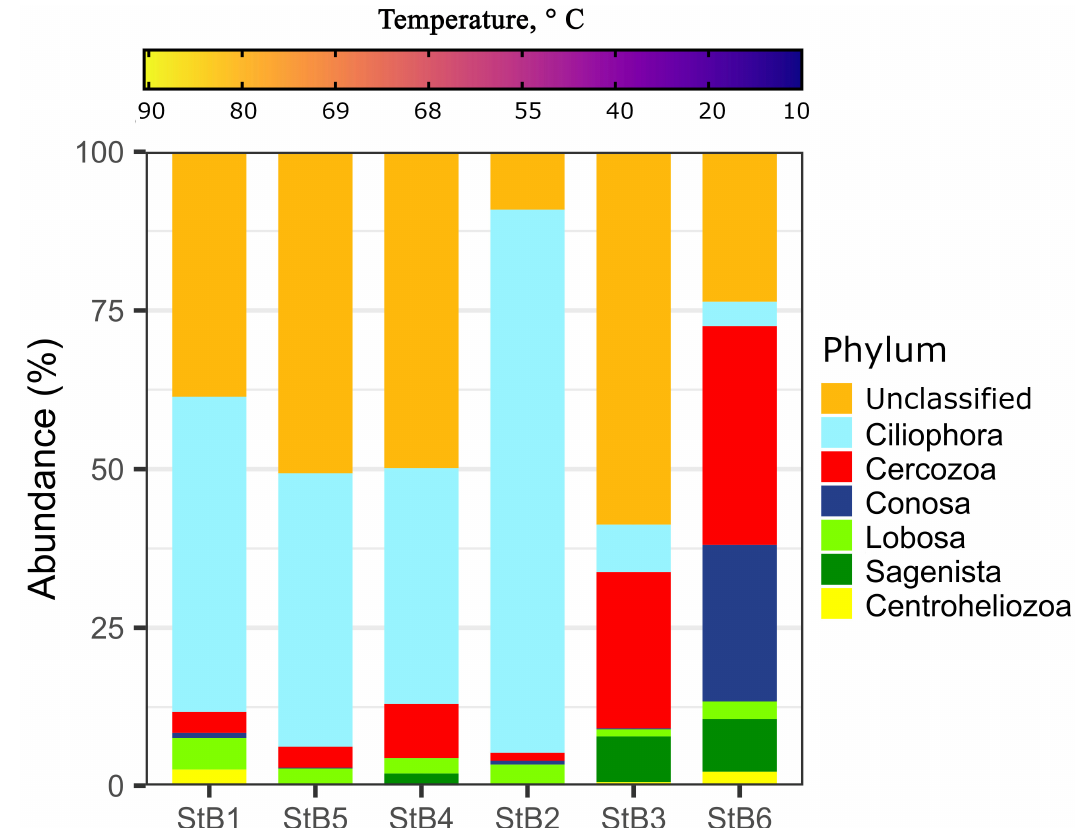
Figure 6. Relative abundances of protists phyla in the microbial biofilms calculated at reads filtration threshold 5%.